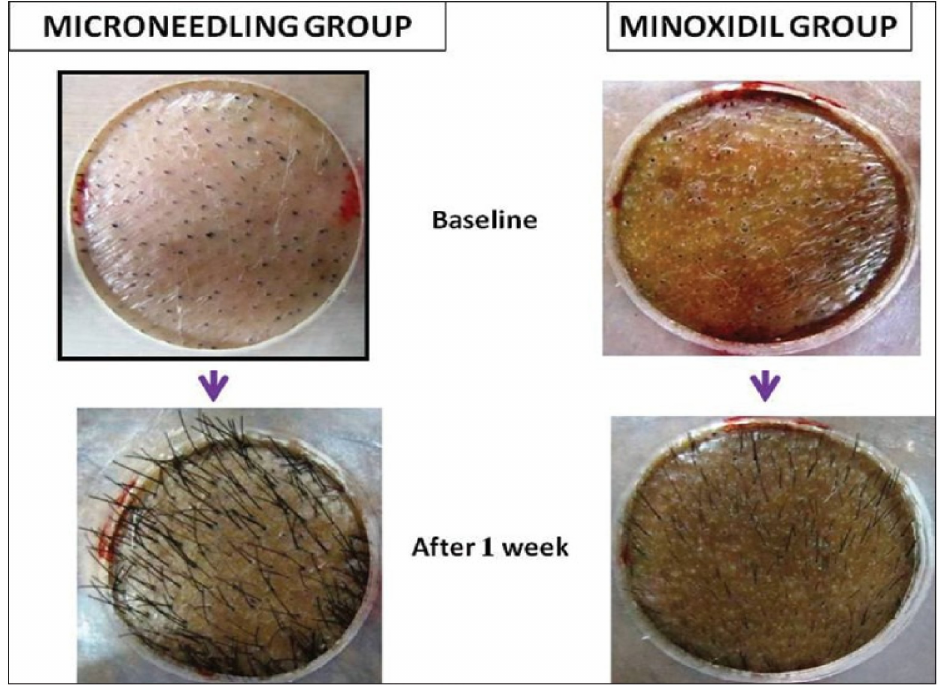
Figure 19. Faster hair re-growth at 1 week noted in Microneedling treated group [215]. Reproduced with permission from Rachita Dhurat et al., A Randomized Evaluator Blinded Study of Effect of Microneedling in Androgenetic Alopecia: A Pilot Study; published by International Journal of Trichology,